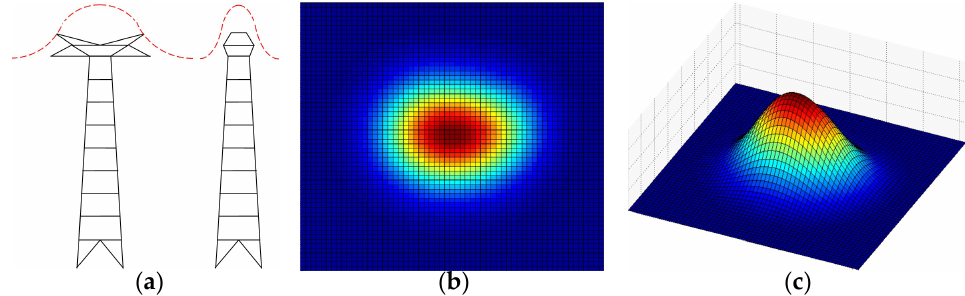
Figure 4. Sketch map of transmission tower and its simplified model of radio interference distribution. ( a ) Front and side views of transmission tower. ( b ) 2D image of bi-GMM. ( c ) 3D image of bi-GMM.